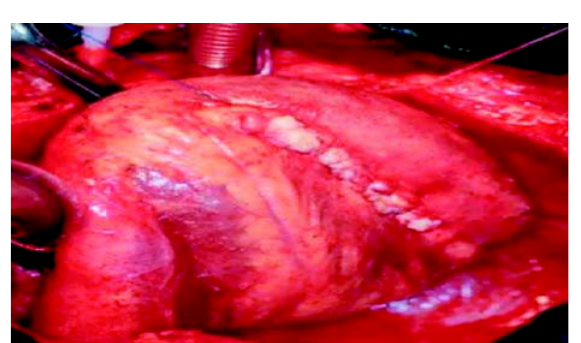
concluído.Fig. Fig. 6 – Rotura cardíaca subaguda. “Pseudo-aneurisma ventricular” tratamento cirúrgico